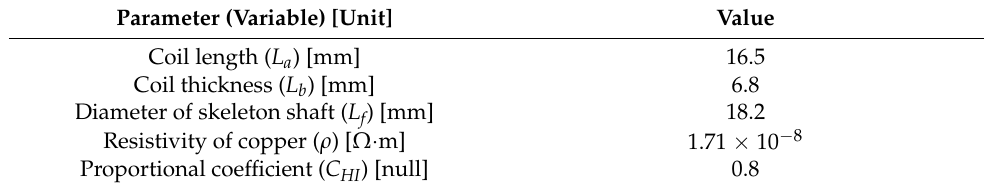
Table 2. The main parameters of the skeleton and